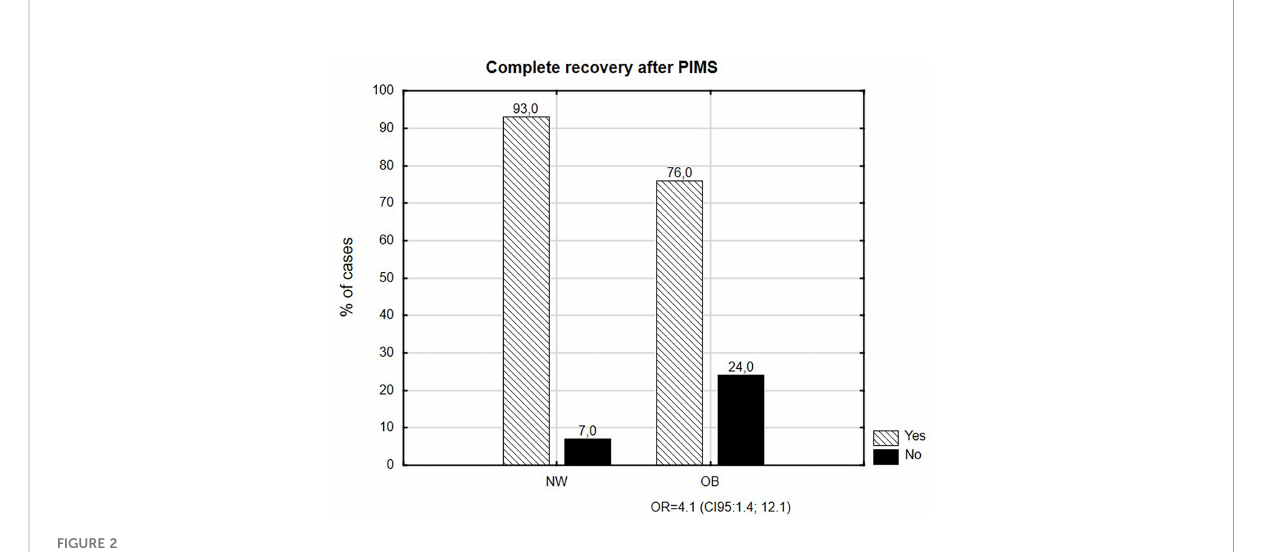
FIGURE 2 Complete recovery after